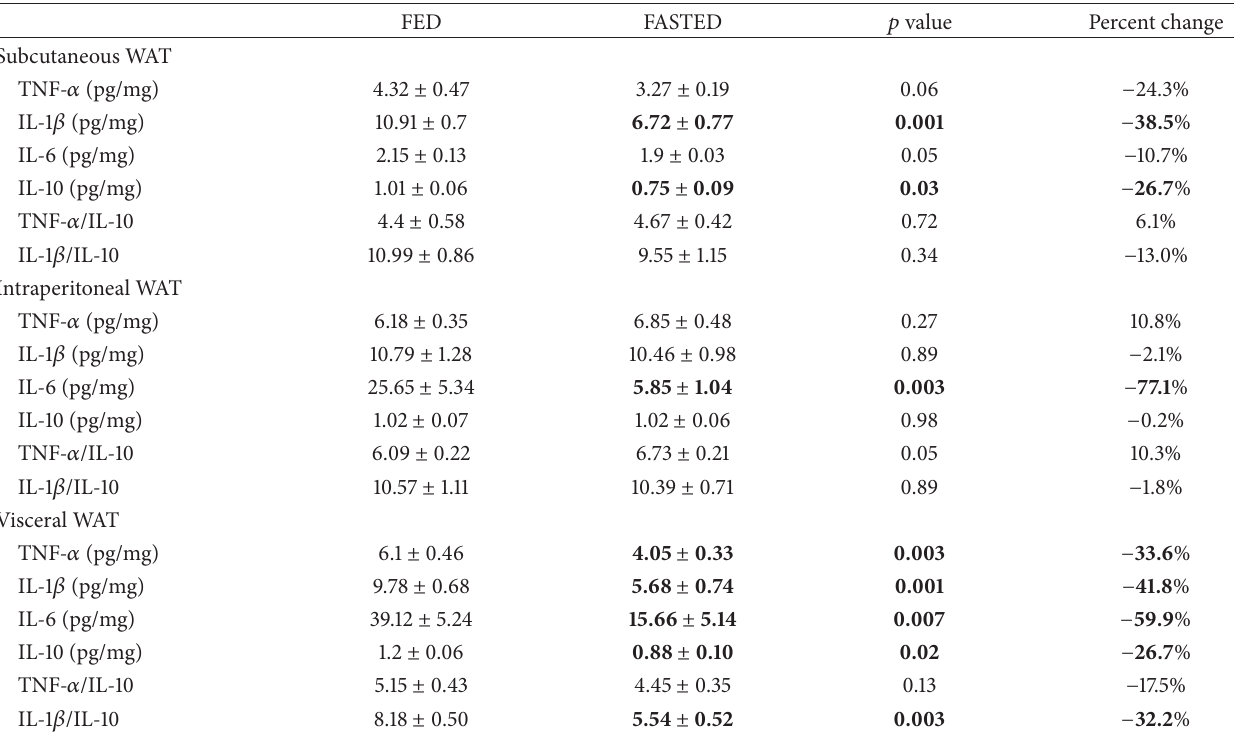
Table 2: Effects of a 24 h fast on basal cytokine concentrations in WAT. Differences between WAT cytokines in fed (FED + 0IS, 𝑛 = 8 )